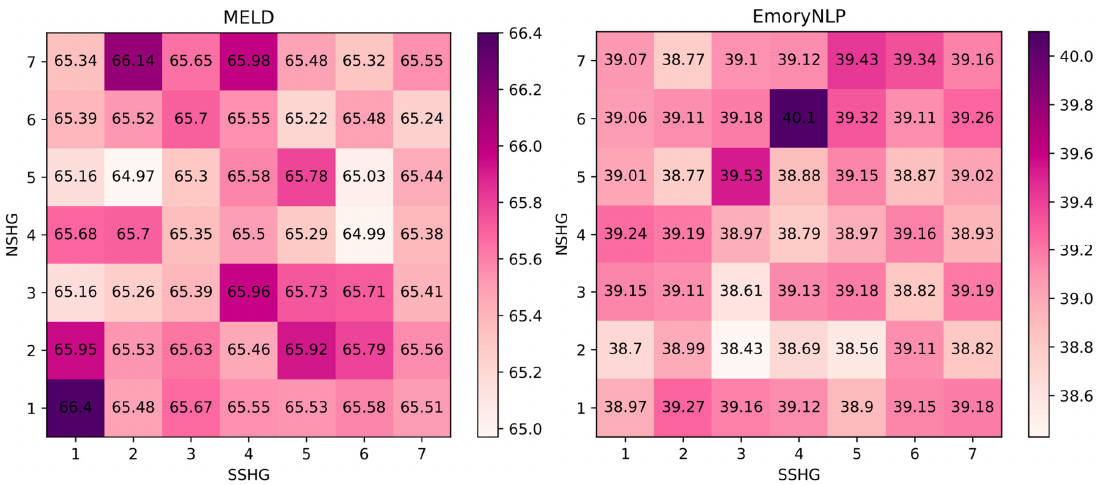
Figure 3. Effect of the depth of the GNN. We report the weighted F1 score on the MELD and EmoryNLP datasets. The darker the color, the better the performance.